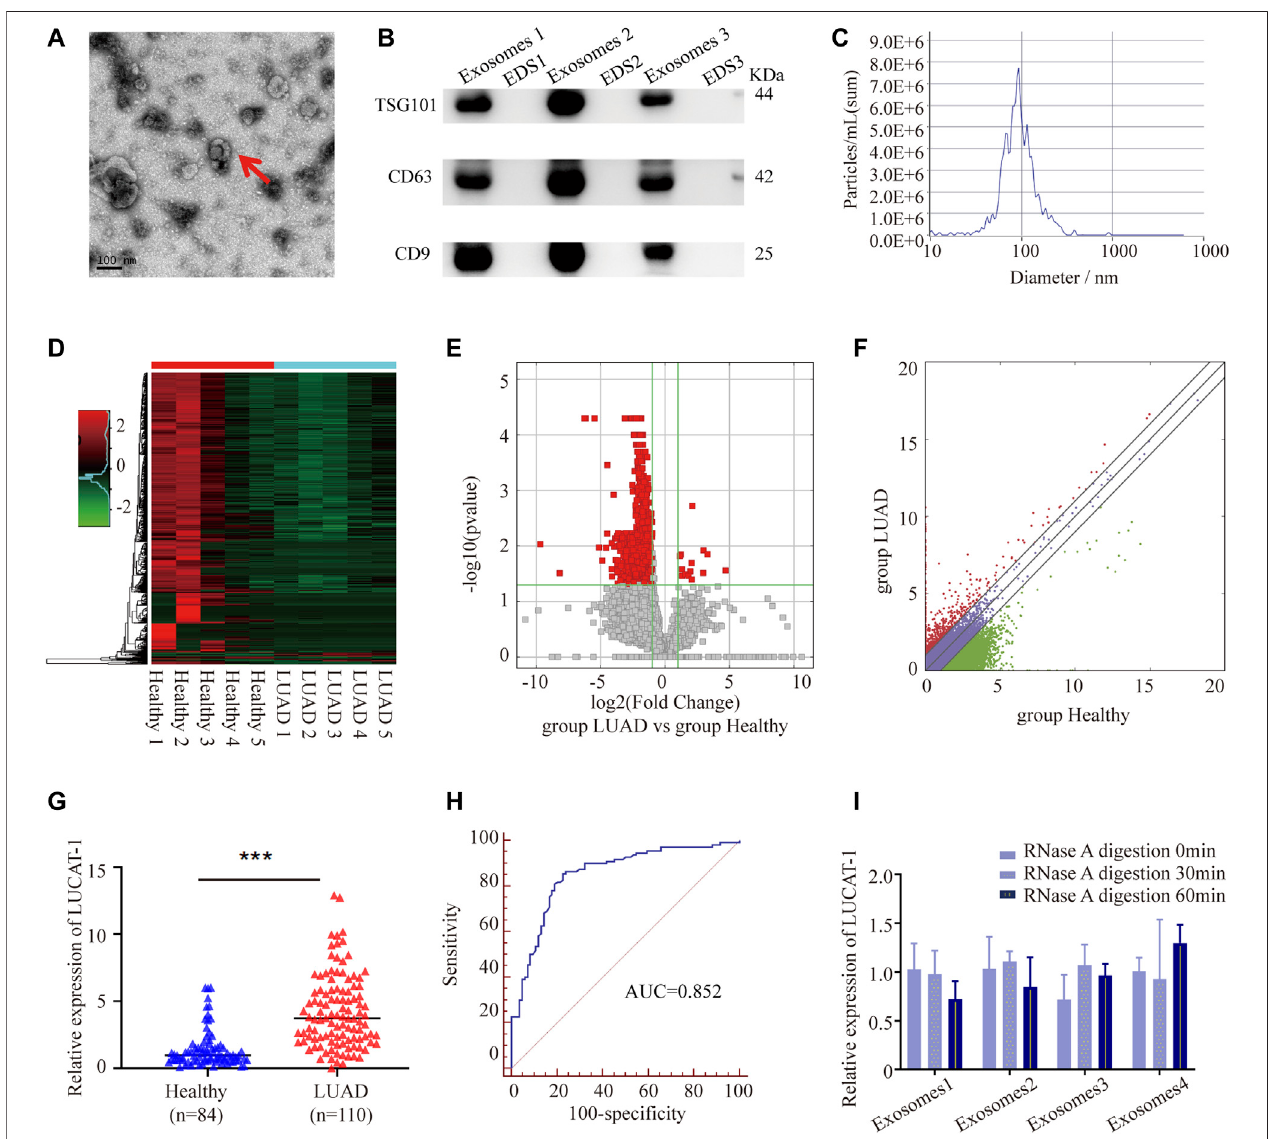
FIGURE 1 | Tumor-originated exosomal LUCAT1 as a circulating biomarker for LUAD. (A) Transmission electron microscopy images of exosomes. Scale bar: 100 nm. (B) Western blot images of exosomal markers (TSG101, CD63, CD9). (C) Size distribution and concentration of serum exosomes. Heatmap (D) , volcano plot (E) andscatterplot (F) showedthedifferentiallyexpressedserumexosomallncRNAsfromthehigh-throughputsequencinganalysis. (G) Comparisonofserumexosomal LUCAT1 expression between LUAD patients and healthy controls detected by qRT-PCR. (H) ROC curves for the determination of the diagnostic performance of serum exosomalLUCAT1. (I) ComparisonoftheexpressionlevelofLUCAT1beforeandafterRNaseAtreatment. p valueswerecalculatedusingtwo-sidedpairedt-test (* p < 0.05; ** p < 0.01; *** p < 0.001).